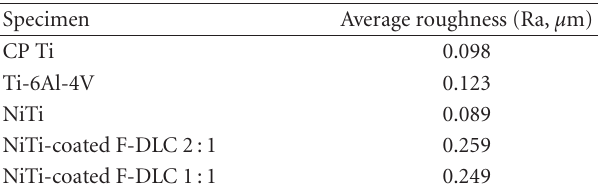
Table 4: Average surface roughness of